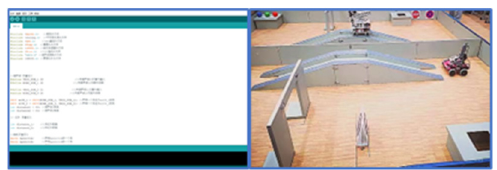
Figure 19. Experimental pictures.